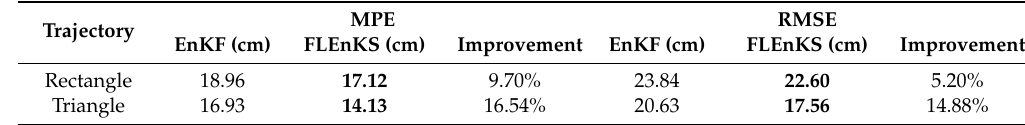
Table 3. Positioning Errors of EnKF and